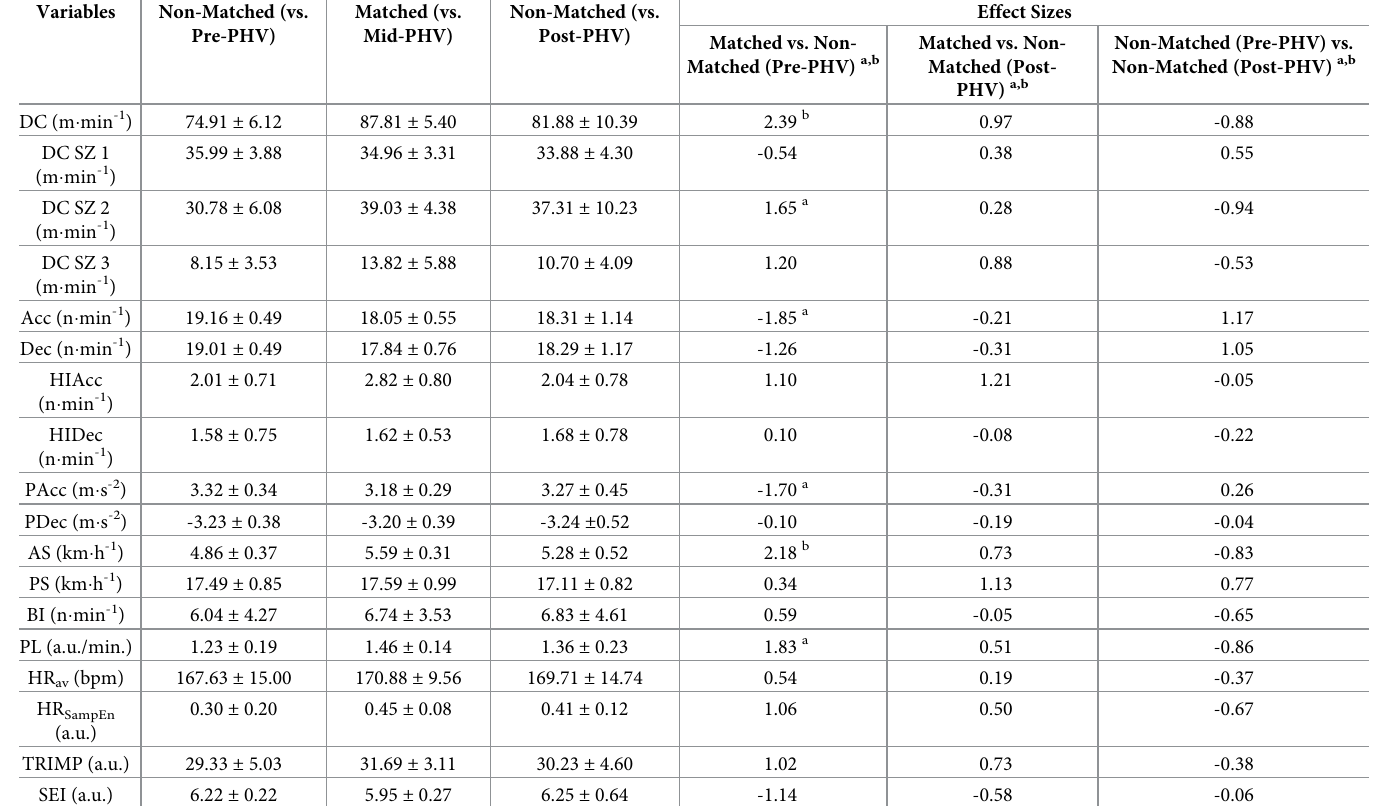
Table 3. Mean ( ± SD) physical and tactical performance produced by Mid-PHV during game formats.